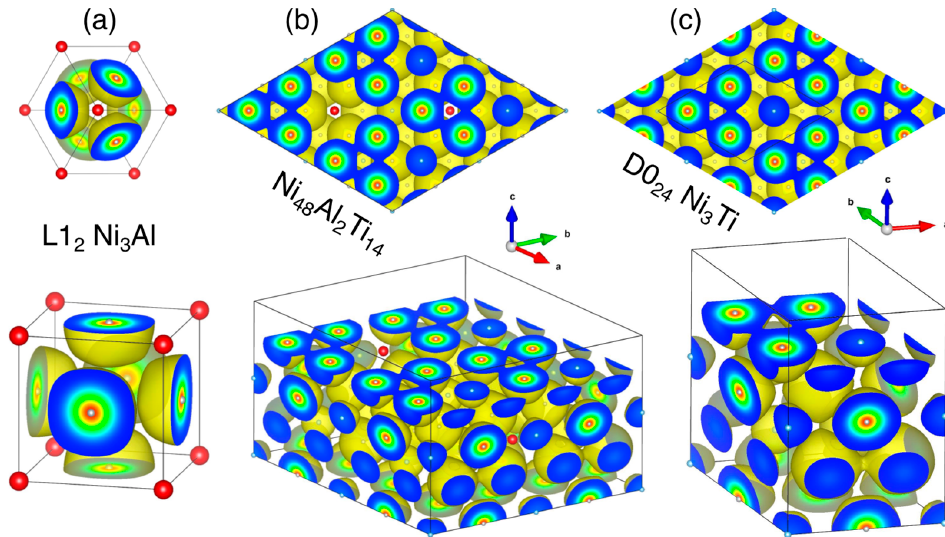
Figure 6. 0.05 e − /Å 3 iso-surfaces of valence electron density in ( a ) cubic L1 2 Ni 3 Al at x =0, ( b ) hexagonal Ni 48 Al 2 Ti 14 (see Figure 2c) at x = 7/8, and ( c ) D0 24 Ni 3 Ti at x =1, with Ni (grey), Al (red), and Ti (blue) atoms. The upper panel shows cubic 111 ( a ) and hexagonal 0001 ( b , c ) projections.